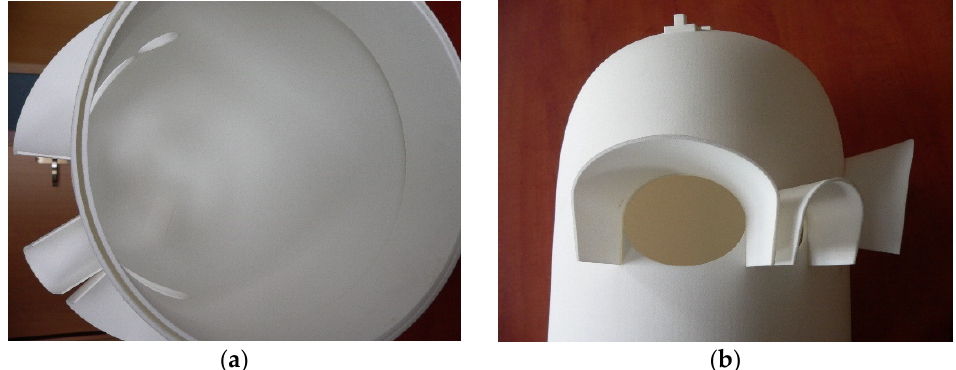
Figure 5. Detailed view of the printed instrument housing prototype; ( a ) visible 5mm-broad gap between the covering layers and ( b ) protective roofs mounted above the aiming holes.